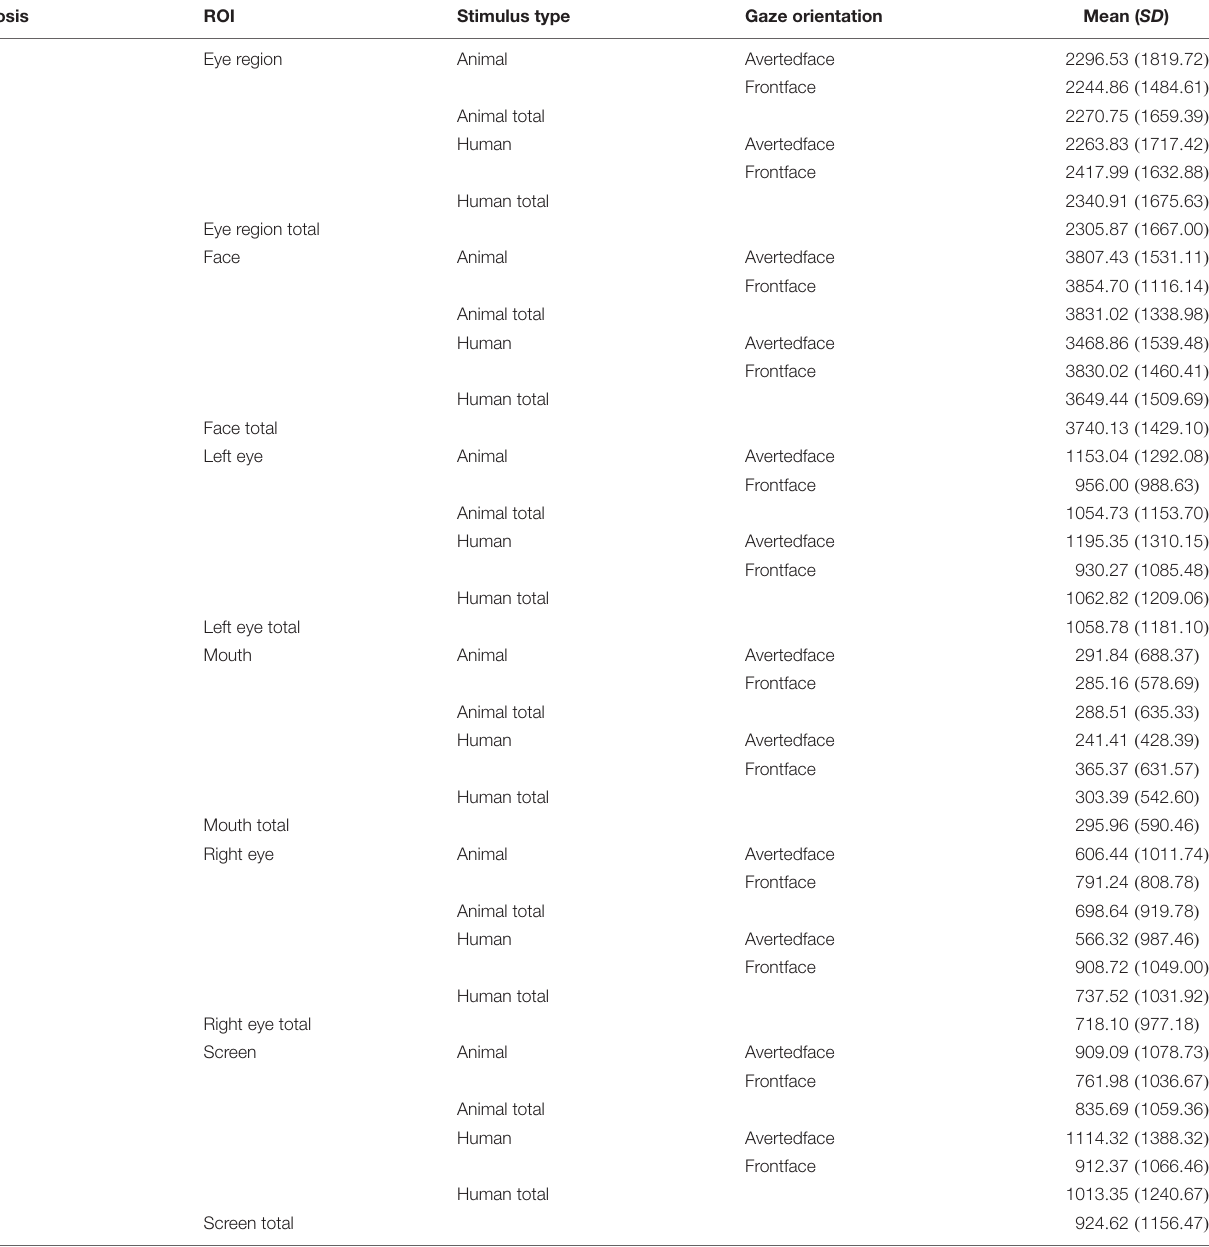
TABLE 3 | Mean and SD values of gaze fixation duration on all ROIs of human and animal images for TD participants. Diagnosis ROI Stimulus type